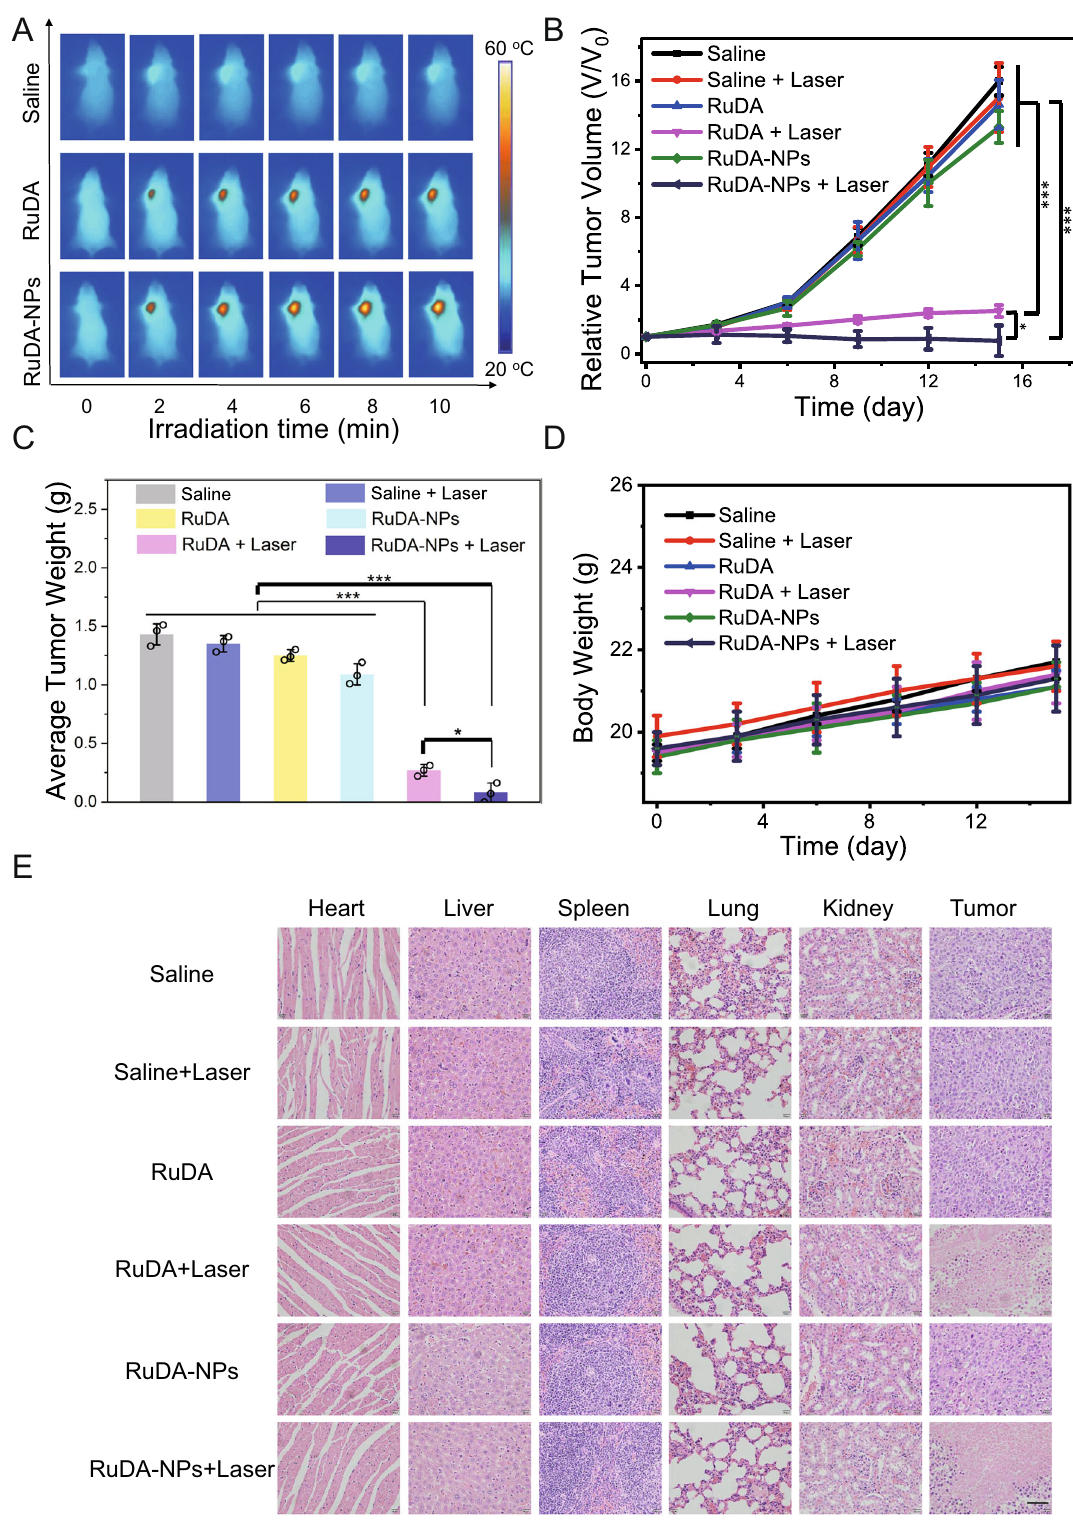
Fig. 8 In vivo phototherapy ef fi cacies of RuDA and RuDA-NPs on tumors. A IR thermal images of MDA-MB-231 tumor-bearing mice irradiated with 808 nm laser for different time at 8 h post injection. A representative image of four biological replicates from each group is shown. B Relative tumor volume and C average tumor weights for different groups of mice during the therapeutic process. D Body weight curves of different groups of mice. Irradiation was performed with 808 nm laser at 0.5 W cm − 2 for 10 min (300 J cm − 2 ). Error bars, mean ± SD ( n = 3). Unpaired, two-sided t tests * p < 0.05, ** p < 0.01, and *** p < 0.001. E H&E staining images of major organs and tumors from different treatment groups, including Saline, Saline + Laser, RuDA, RuDA + Laser, RuDA-NPs, and RuDA-NPs + Laser groups. Scale bars: 60 μ